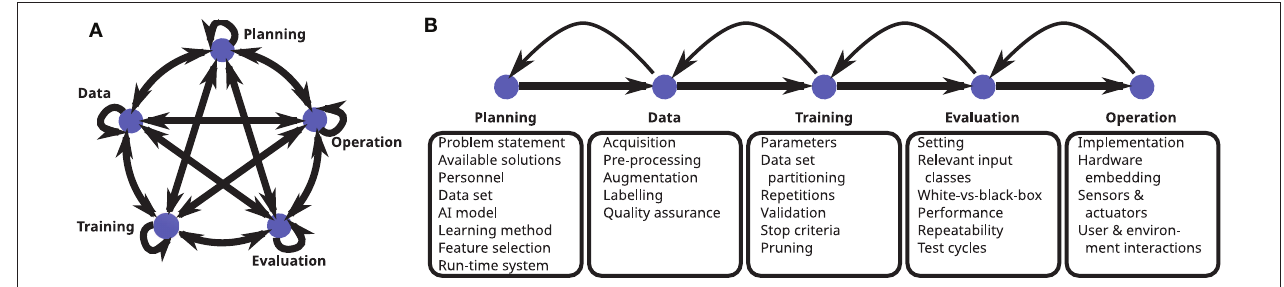
FIGURE 3 | The development of cAI applications may be broken down into phases. (A) In reality, the development process is non-sequential, often relies on intuition and experience and involves many feedback loops on different levels. The developer tries to find the quickest route to an operational AI system with the desired properties. (B) For a simplified presentation, sequential phases are depicted. Here prominent functional components are shown for each phase. Besides this functional perspective, the phases may be considered in terms of robustness, data protection, user acceptance or other aspects.